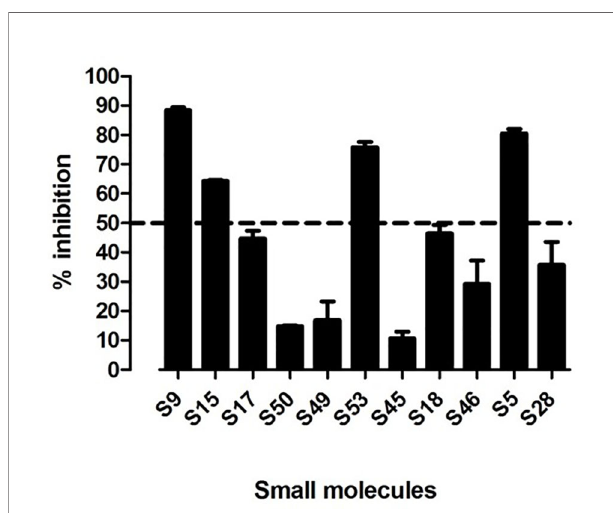
FIGURE 3 | 11 top scoring small molecules were tested for blocking APO peptide binding to APS3v-HLA-DR3 in ELISA. Figure 3 shows the in vitro screening results of the 11 top scoring small molecules identi fi ed in the virtual screen. 4 small molecules (S9, S15, S53 and S5) inhibited APO peptide binding to APS3v-HLA-DR3 by more than